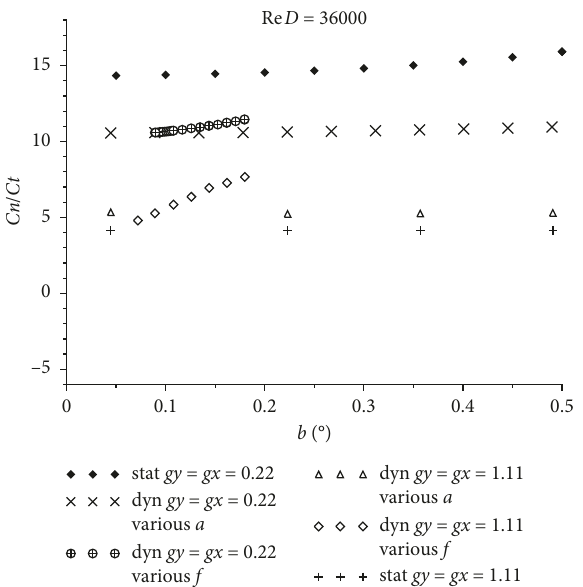
Figure 16: Evolution of Cn / Ct as a function of the angle b , comparison between steady and dynamic simulations.